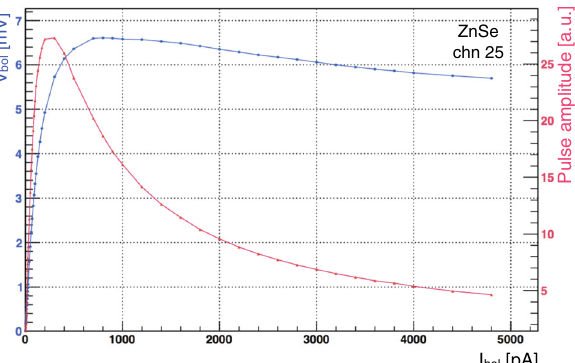
Fig. 22 Characteristic load curve of a CUPID-0 ZnSe crystal oper- ated with a Ge-NTD thermal sensor. The figure shows how varying the detector biasing voltage acts on the signal amplitude (red) and on the voltage drop across the sensor resistance (blue)